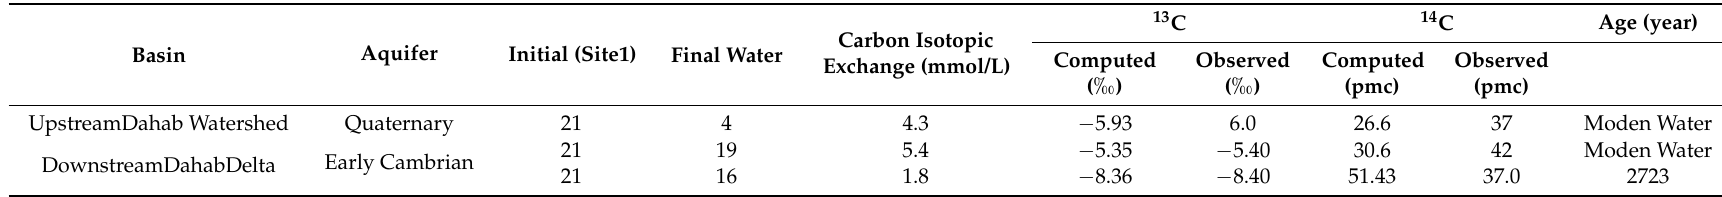
Table 3. NETPATH modeling results (mmol/L) for the El-Dabaa Area. Positive values mean the phase is going into solution, while negative values mean the phase is being removed from the